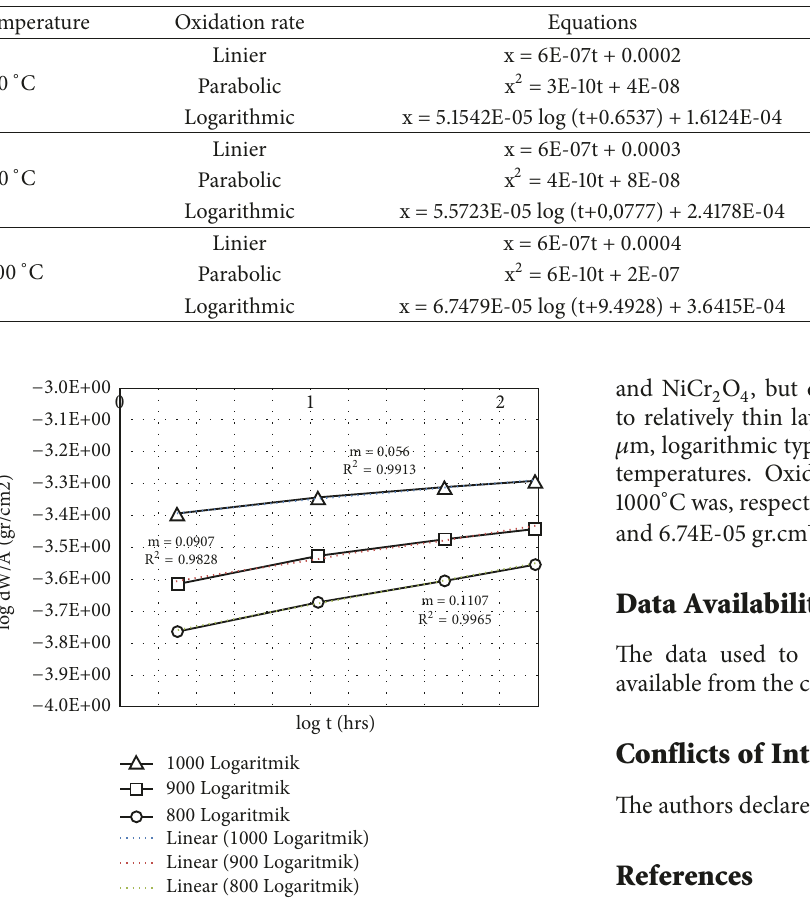
Figure 11: Double-logarithmic plot